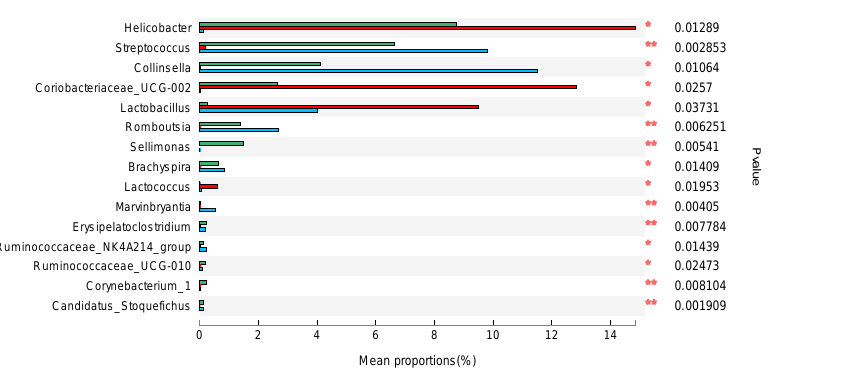
Figure 9. Top ten genuses analyzed using the Kruskal–Wallis test that have significant differences in relative abundance among CSAA, CDAA, and PPC groups, * p < 0.05, ** p < 0.01.